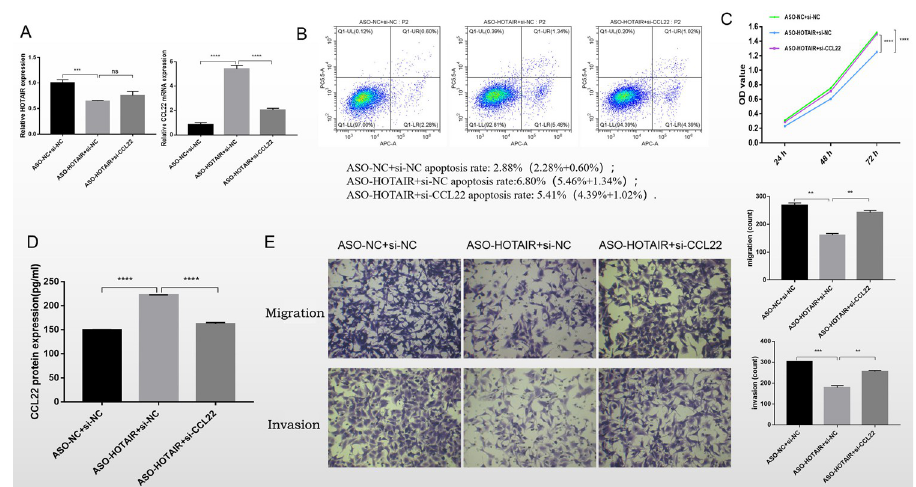
Fig 3. The inhibition of LncRNA HOTAIR and interference with CCL22 showing the changes in cell function among the ASO-NC+si-NC, ASO-HOTAIR+si-NC and ASO-HOTAIR+si-CCL22 groups. A: The HOTAIR and CCL22 mRNA expression examined by RT-qPCR B: Cell apoptosis detected by Flow cytometry. C: The cell proliferation tested by MTS assay. D: The CCL22 protein expression tested by ELISA. E: The cell migration and invasion detected by Transwell assay. �� , P < 0.05; ��� , P < 0.01; ���� , P < 0.001;ns, no